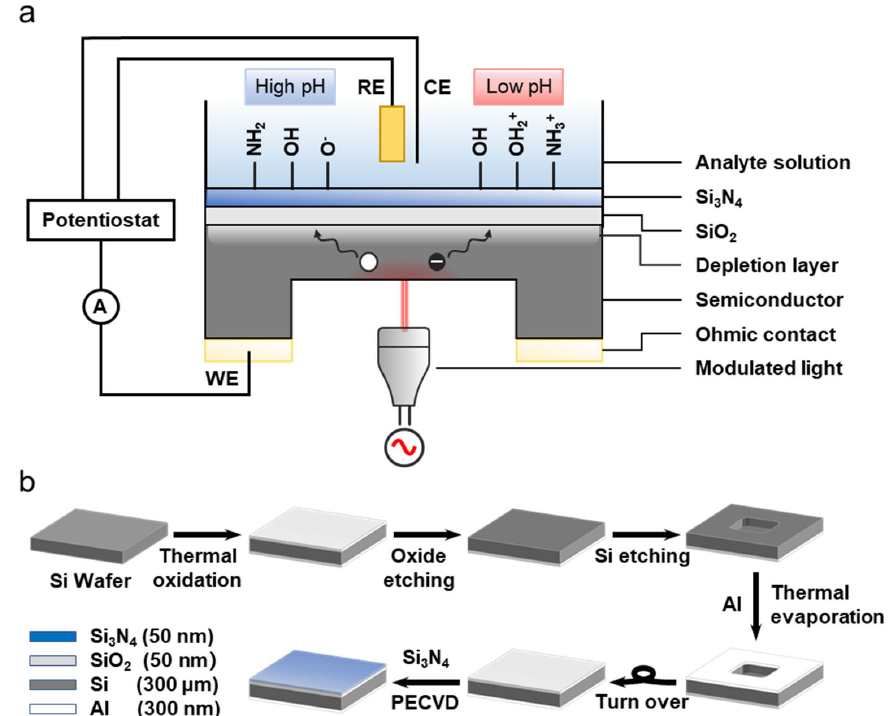
Figure 2. The detection principle and fabrication of the thinned LAPS chip. ( a ) The principle of acidic metabolites detection by the thinned LAPS chip. ( b ) The processing flow of the thinned LAPS chip.